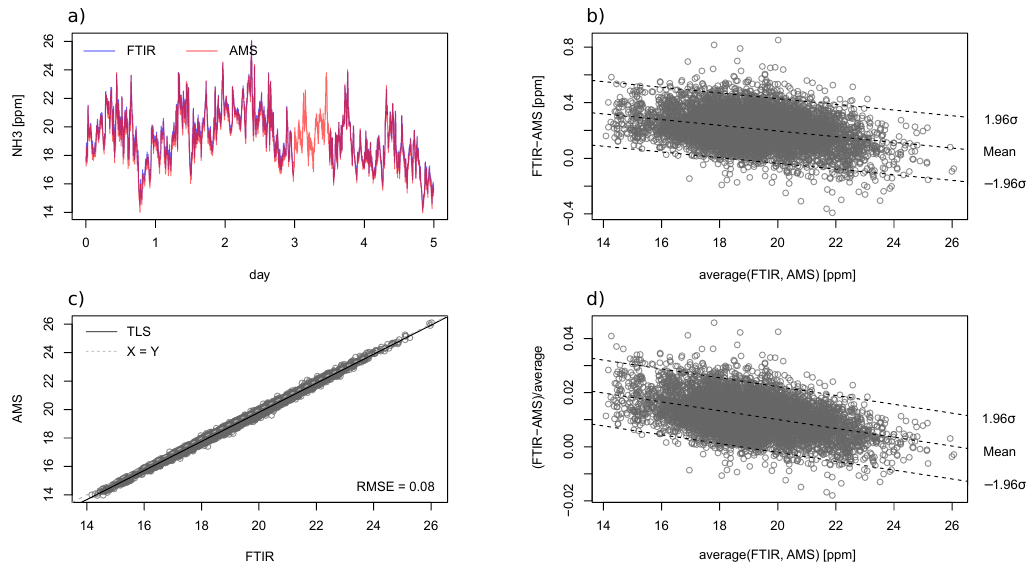
Figure 9. Comparison between the AMS and FTIR measurement system on NH 3 measurement. The sub-plots are: the ( a ) time-series plot, ( b ) Bland–Altman plot of absolute differences, ( c ) scatter plot, and ( d ) Bland–Altman plot of relative difference. The dashed lines in the Bland–Altman plots represent the regression line and 95% bound of